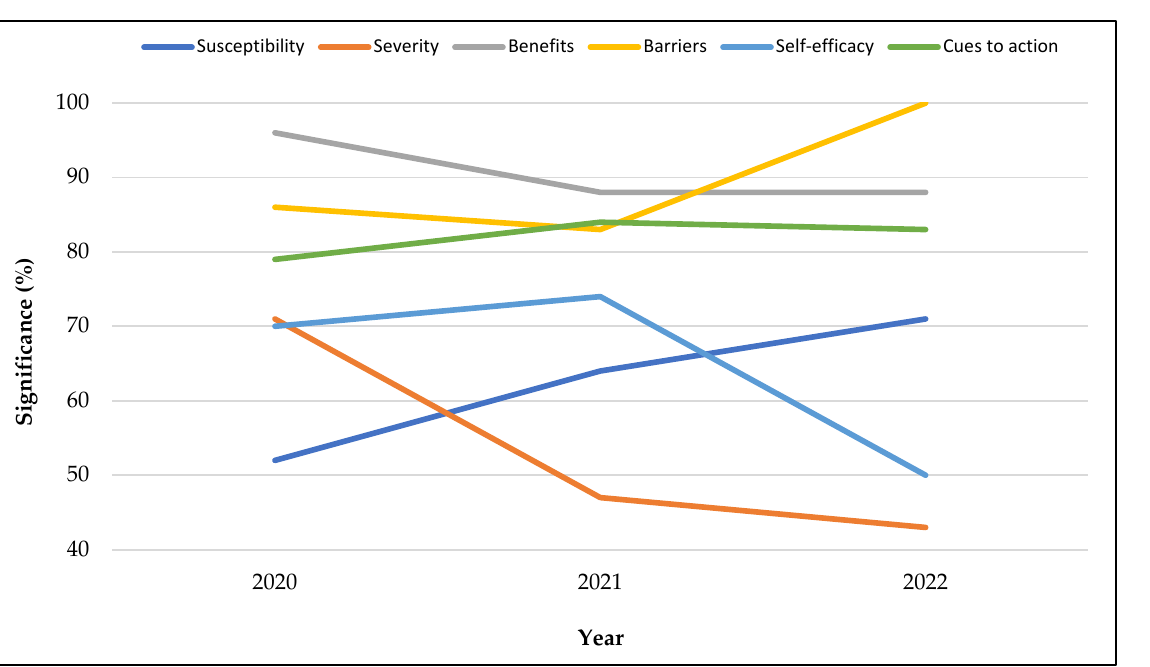
Figure 5. Major HBM modifying variables associated with vaccination intention.